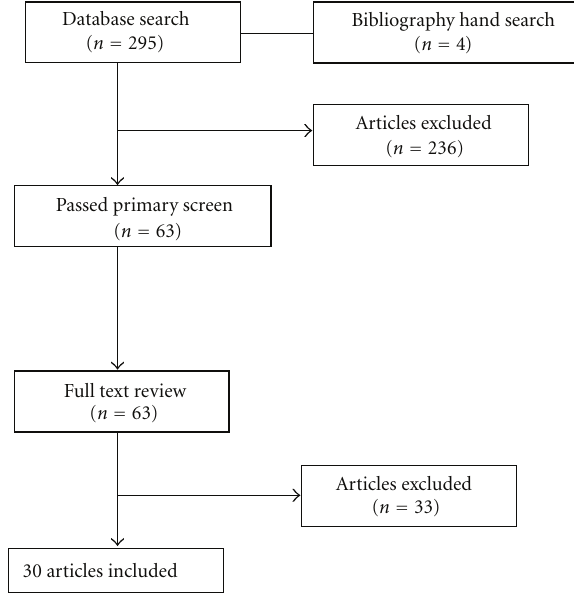
Figure 1: Identification, screening, eligibility, and inclusion of